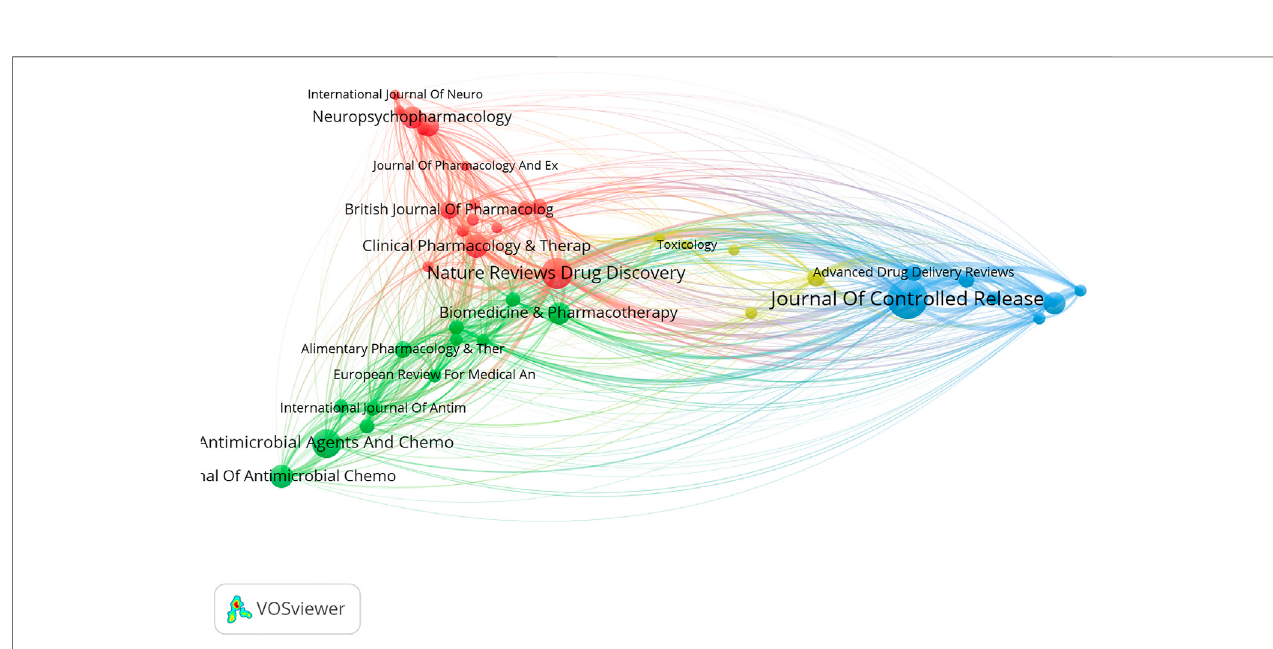
FIGURE 6 | Map of collaborative networks among journals of high-impact papers in pharmacology and pharmacy research around the world.